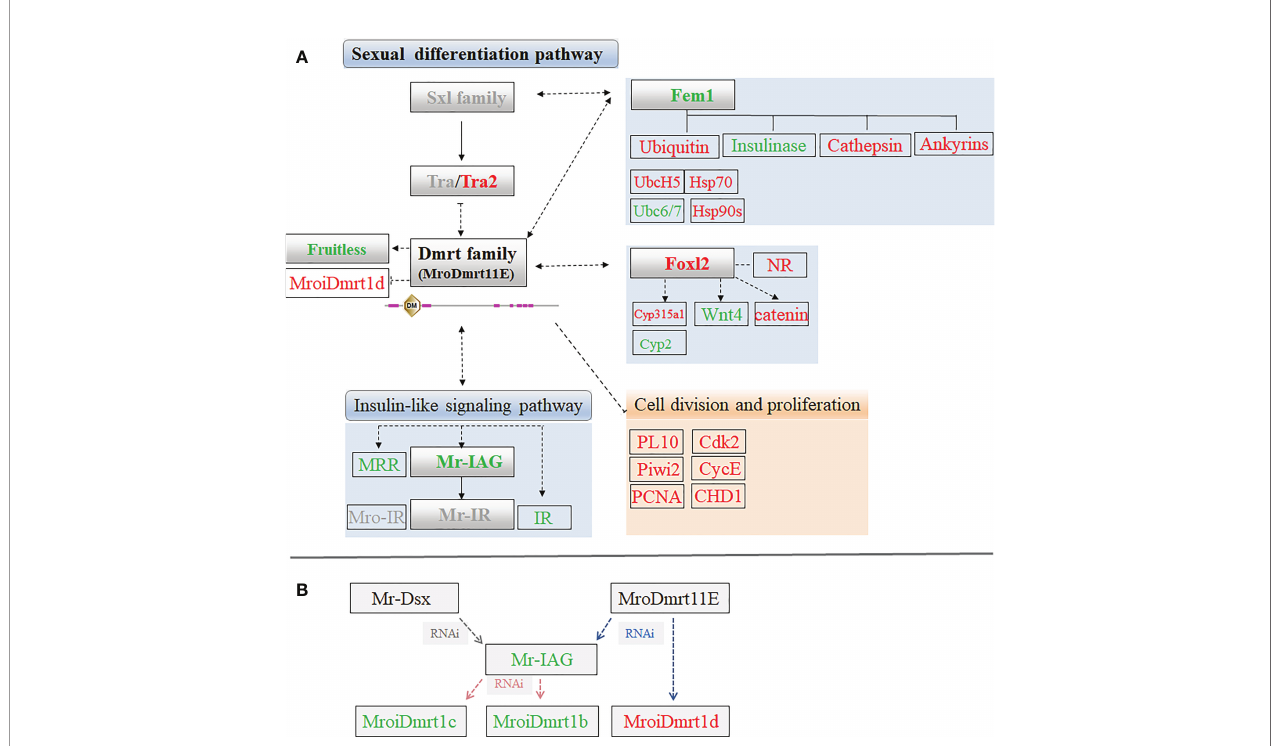
FIGURE 4 | (A) The sex-related candidate unigenes enriched in putative sexual differentiation pathway by the comparative transcriptomic analysis of MroDmrt11E knockdown. The primary upregulated transcripts (red color) and the downregulated transcripts (green color) were brie fl y pro fi led in the signaling pathway. The genes with gray color possibly participated in the sexual differentiation but did not show signi fi cant differential expression by MroDmrt11E knockdown. (B) The brief relationship among Dmrt gene family and Mr-IAG was summarized to evaluate their potential in fl uences involved in the sexual differentiation of M. rosenbergii